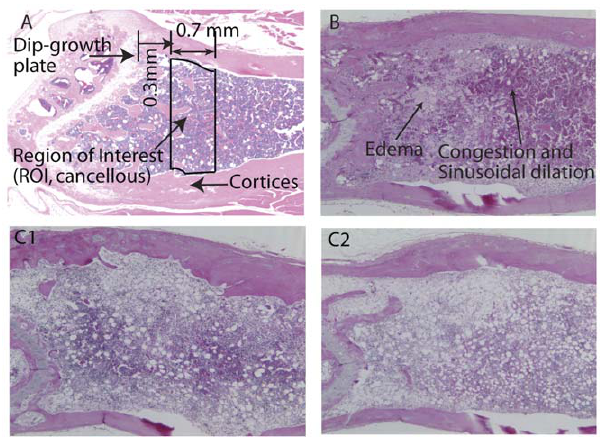
Figure 2. Schematic representation of bone and marrow. A. region of interest in sagittal view of a normal control mouse. B. Sagittal section of bone marrow from an intact mouse 8 days post-irradiation. Note the areas of congestion and sinusoidal dilation characterized by increased density of red blood cell within the expanded vascular spaces; also present are areas of edema characterized by increased volume of pale pink fluid in the interstitial spaces. C. Sagittal sections of bone marrow 30 days after irradiation in intact (C1) and OVX (C2) mice. Note the more intensely purple areas indicative of higher hematopoietic activity in C1 compared with C2, as well as expanded adipose in C2 compared with C1. Figure 2 A). The cancellous bone is composed of trabecular bone matrix and marrow. The cancellous bone volume fraction (BV/ TV %; i.e. the ratio of the segmented trabecular bone volume to the total tissue volume of the region of interest) of the ROI was estimated.